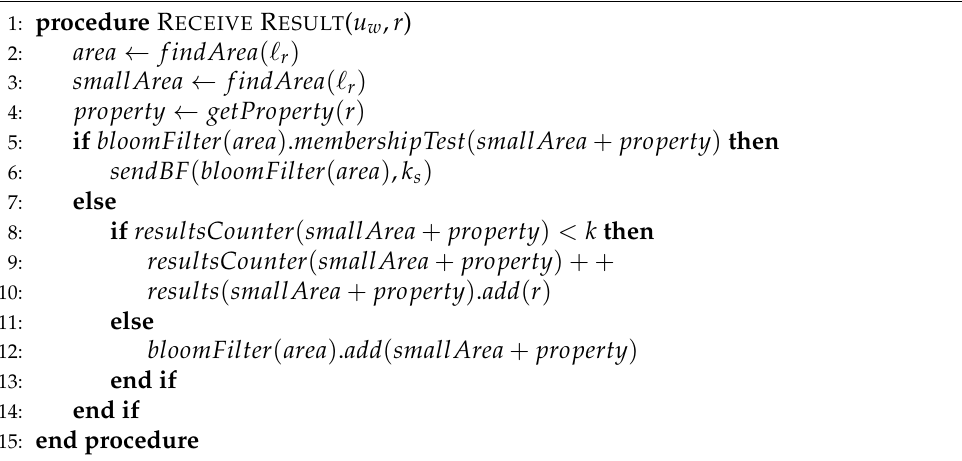
Algorithm 3 Arrival of a new result in the area covered by the ME host